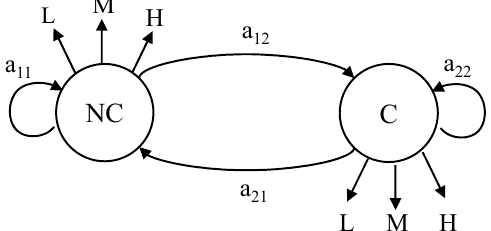
Figure 5. The state diagram for non-calving (NC) state and calving (C).